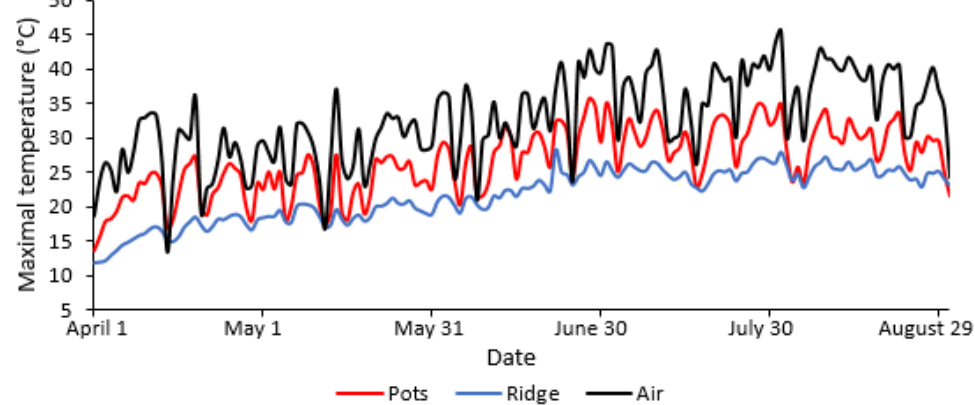
Figure 2. Maximum air temperatures and substrate temperatures for the pots and ridge (as indicated)